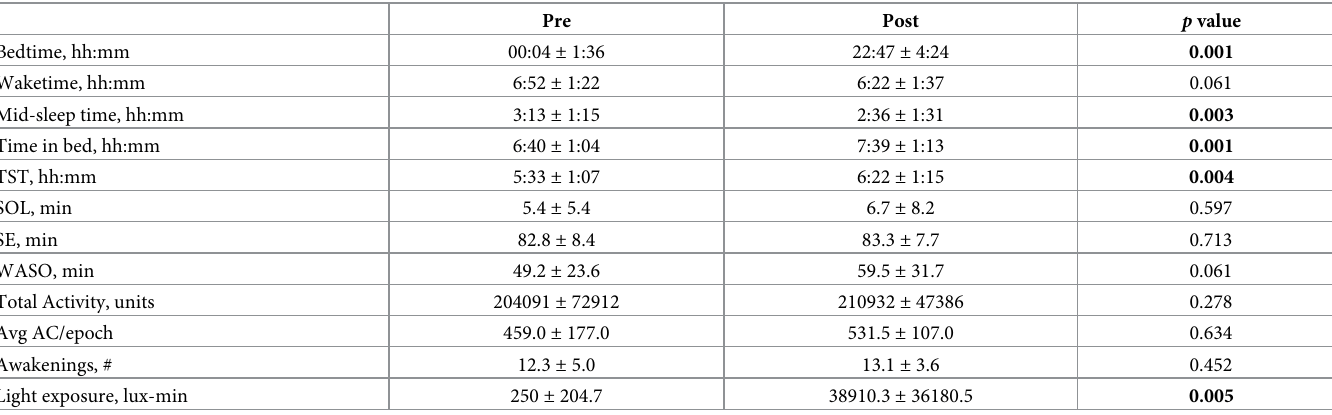
Table 3. Actigraphy metrics pre- and post-morning bright light